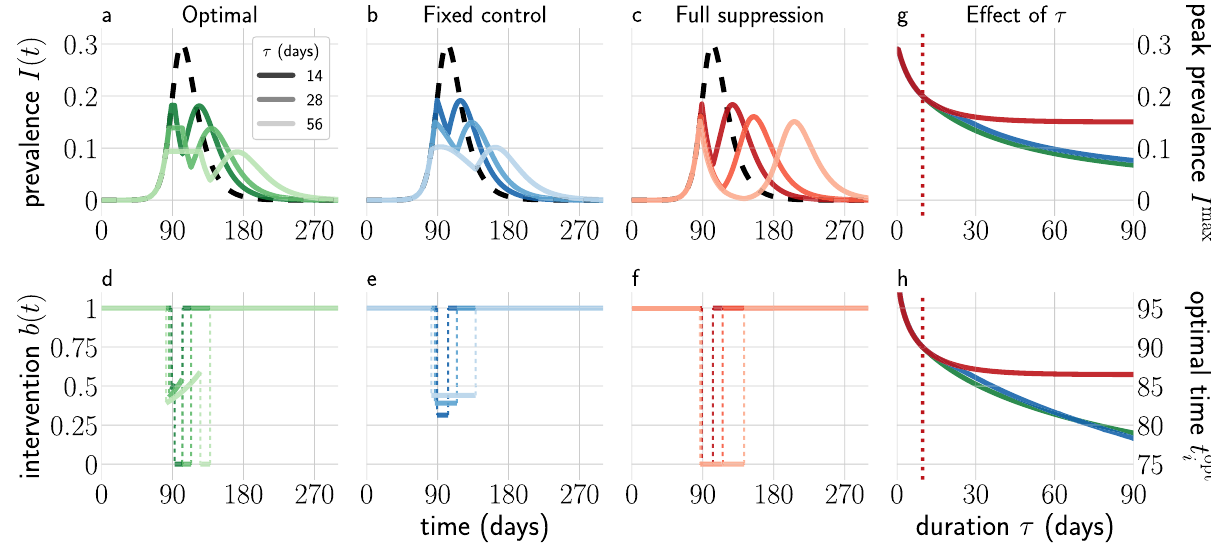
Fig. 1 Interventions reduce peak infection prevalence. a – f Time courses of epidemics under optimal ( a ), fi xed control ( b ), and full suppression ( c ) interventions with three different values of intervention duration τ — 14 days (dark lines), 28 days (intermediate lines), and 56 days (light lines) — and their respective intervention functions b ( t ) ( d – f ). At time t , the basic reproduction number R 0 is reduced to some fraction of its maximum (no intervention) value; b ( t ) gives that fraction. Dashed black line shows time course in the absence of intervention. g , h Effect of the duration τ on the peak infectious prevalence ( g ) and the intervention starting time ( h ) for the optimal intervention (green), the optimized fi xed control intervention (blue), and the optimized full suppression intervention (red). Dotted red line shows the critical value τ crit below which full suppression is the globally optimal intervention. Plotted parameters: R 0 ¼ 3 and γ ¼ 1 days − 1 . See Table 1 for parameter justi fi 14